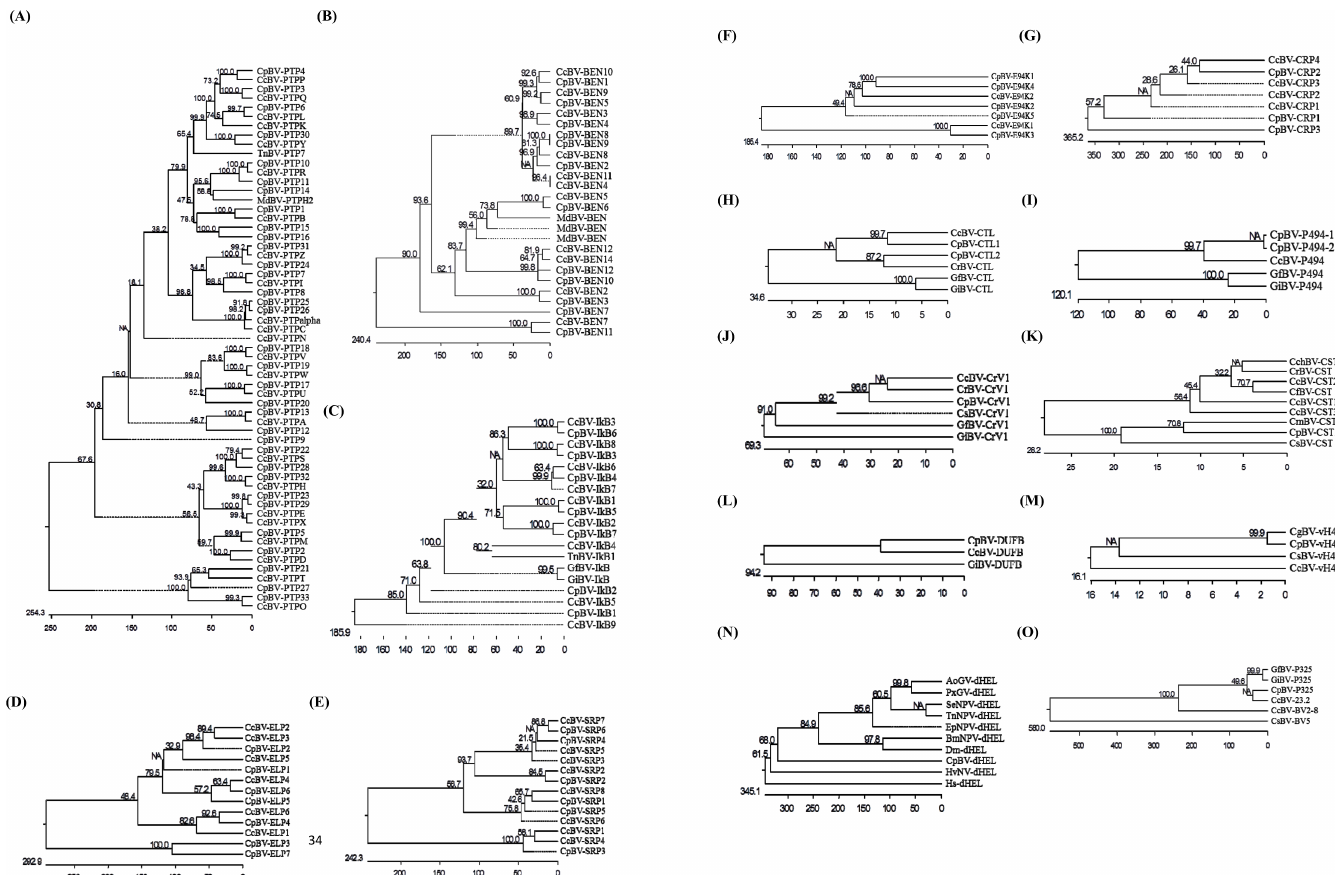
Fig 1. Phylogenetic analyses of 15 CpBV gene families: (A) protein tyrosine phosphatase (PTP) (B) BANP, E5R and NAC1 (BEN) (C) Inhibitor kB (IkB) (D) EP1-like protein (ELP) (E) Serine-rich protein (SRP) (F) E94K (G) Cysteine-rich protein (CRP) (H) C type lectin (CTL) (I) P494 (J) CrV1 (K) Cystatin-like (CST) (L) Duffy- binding (DUFB) (M) viral histone H4 (vH4) (N) DNA helicase (dHEL), and (O) P325. Amino acid sequences of these genes were retrieved from GenBank with accession numbers listed in S3 Table. Amino acid sequences were aligned with MEGA6 [24]. Bootstrap values on branches were obtained with 500 repetitions.